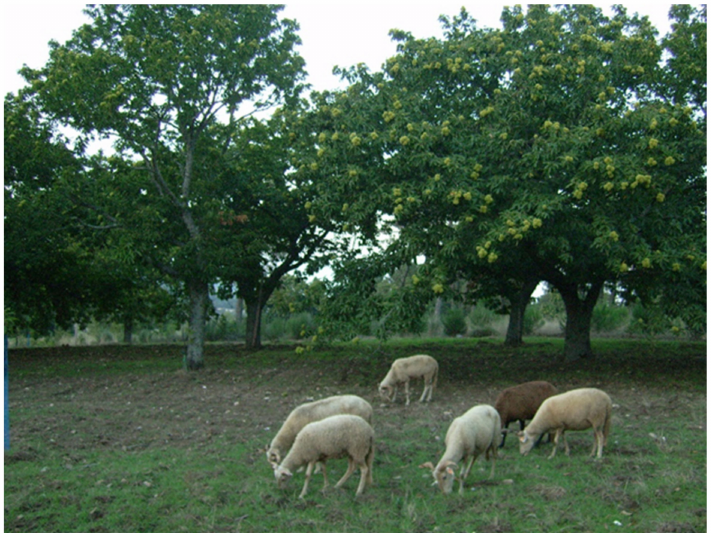
Figure 5. Chestnut orchard associated sustainable agriculture with animal production (photo taken by Bruno Ivo Magalh ã